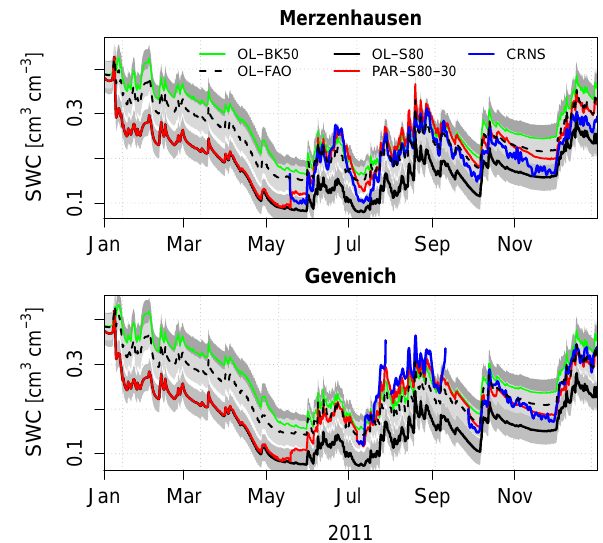
Figure 2. Temporal evolution of simulated soil water con- tent (SWC) retrievals, calculated with open loop (OL- ∗ ) simulations and data assimilation including parameter updating (PAR-S80-30), together with the CRNS SWC retrieval during the first year of sim- ulation at the sites Merzenhausen and Gevenich. Simulated SWC was vertically weighted using the COSMIC operator to obtain the appropriate SWC corresponding to the CRNS SWC retrieval.